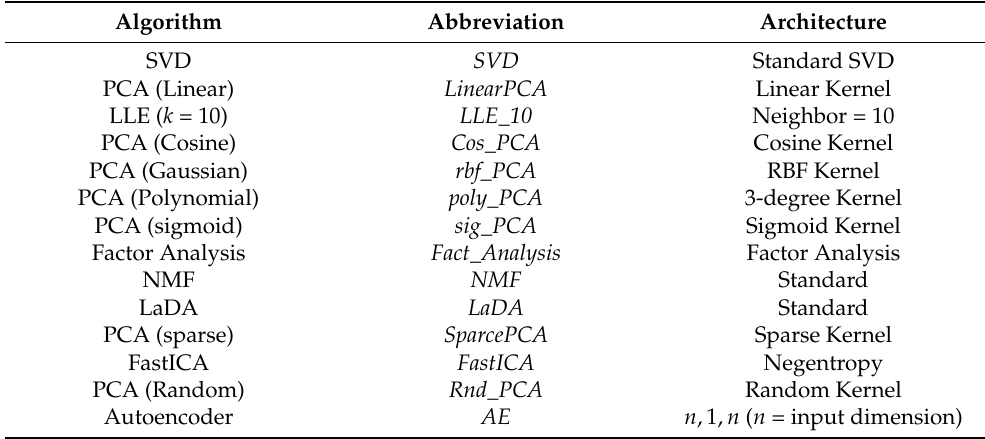
Table 1. Fusion Algorithms and their